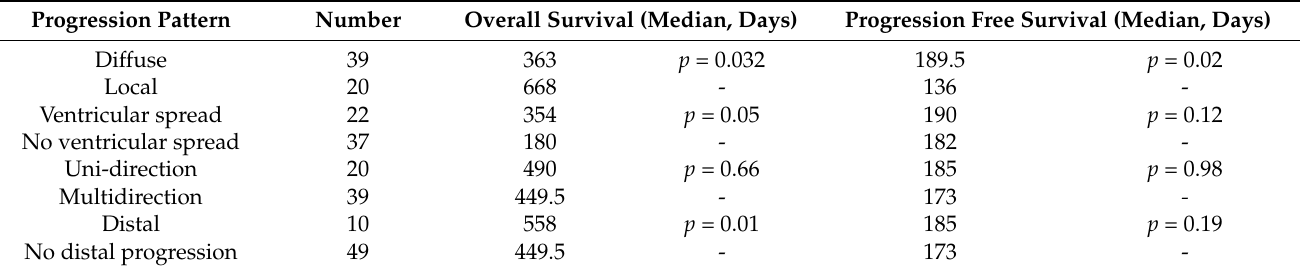
Table 2. The clinical impact of the progression patterns.